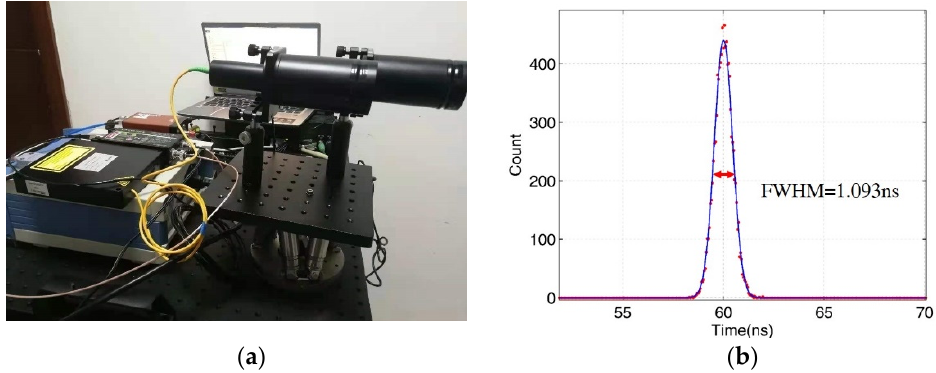
Table 4. System parameters for true random coding photon counting lidar.